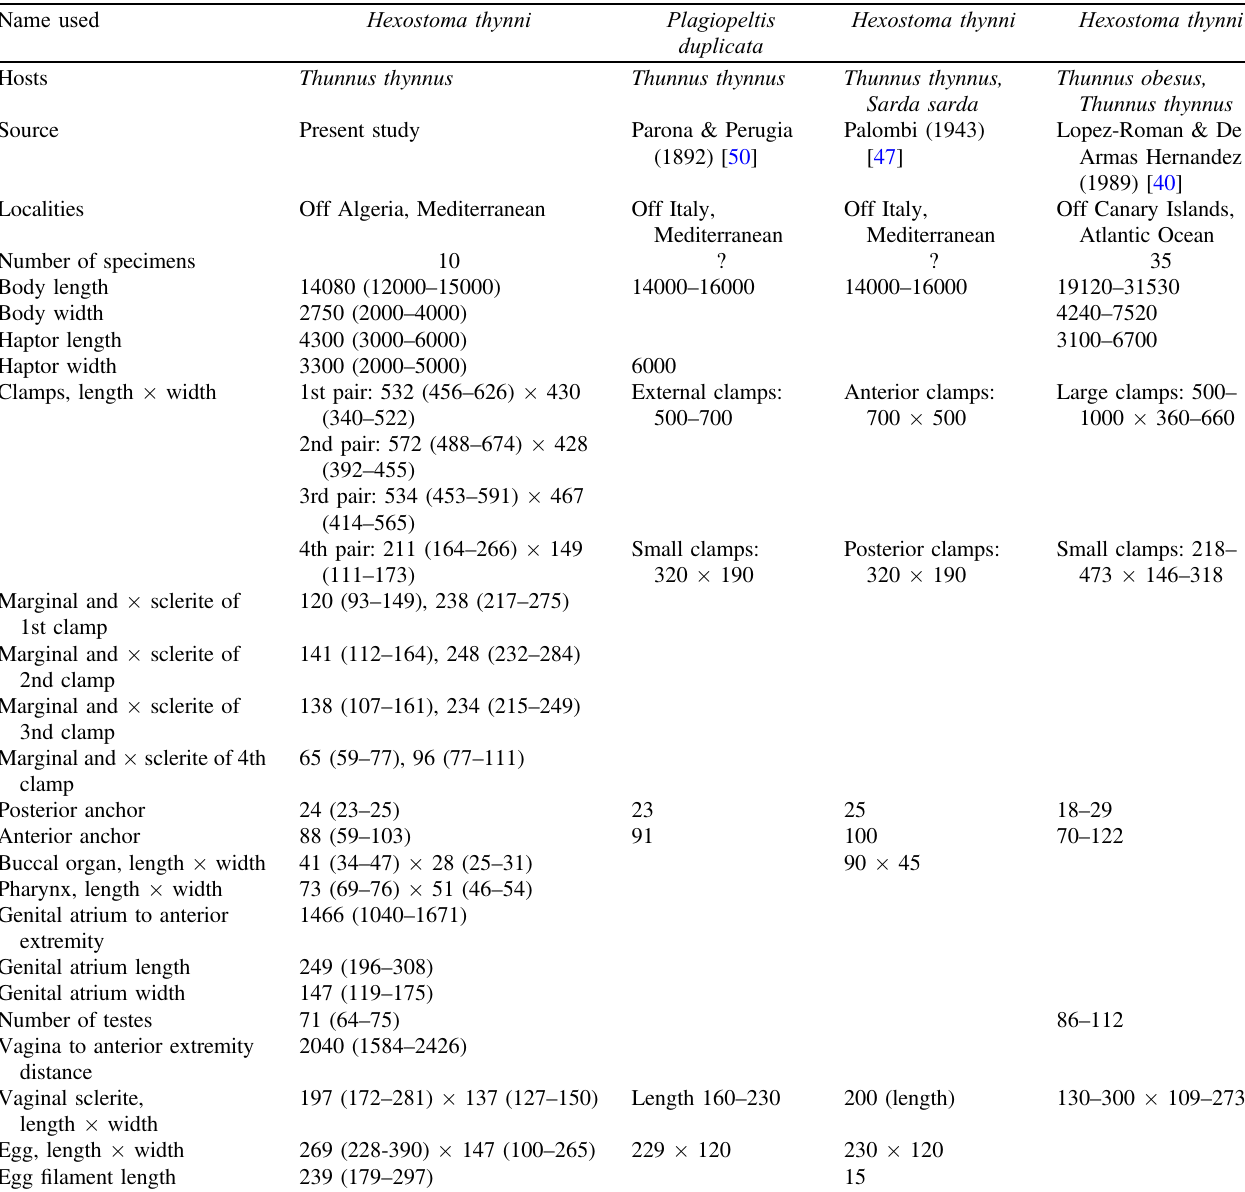
Table 2. Measurements of Hexostoma thynni ( l m), designated under the name Hexostoma thynni or Plagiopeltis duplicata . We consider that specimens described by Parona & Perugia (1892) and Palombi (1943) correspond to H. thynni , such as our own specimens, but that the specimens measured by Lopez-Roman & De Armas Hernandez (1989), which are much larger, probably correspond to another species. Name